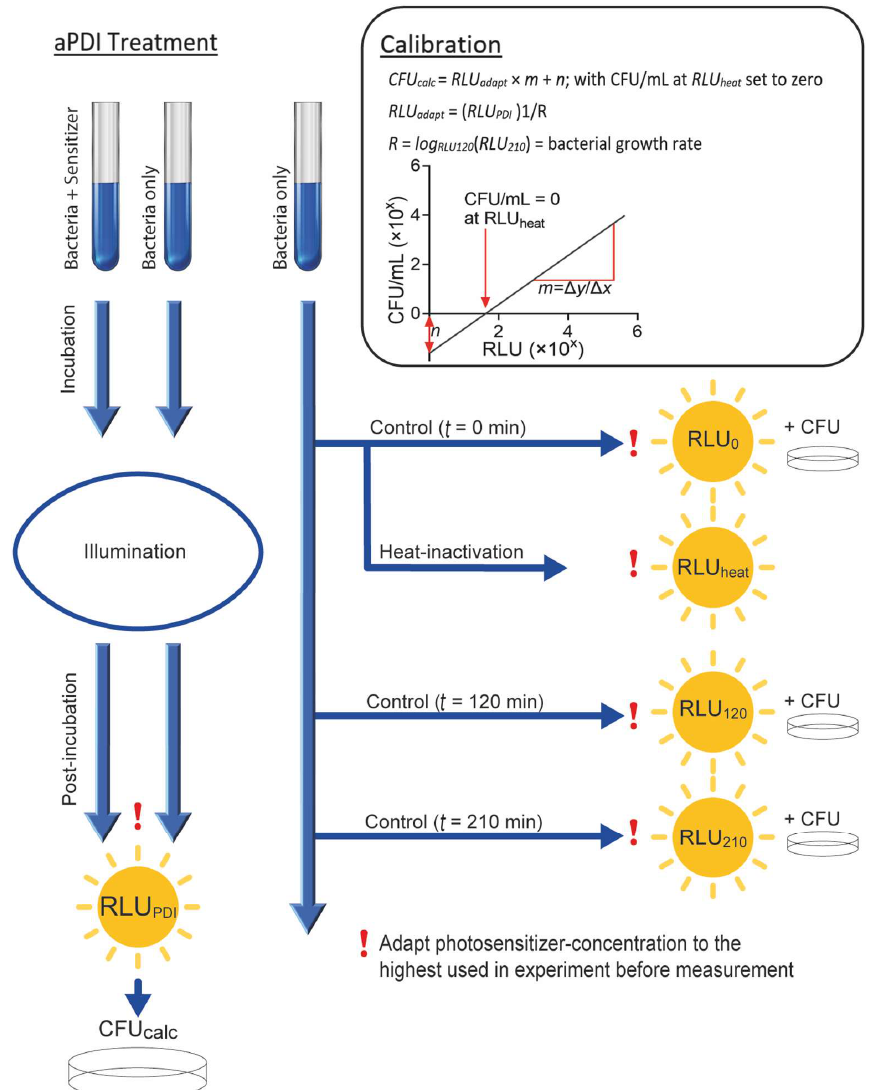
described above, the photosensitizer concentration in all samples must be adjusted to the maximum concentration used in the experiment prior to luminometric measurements.